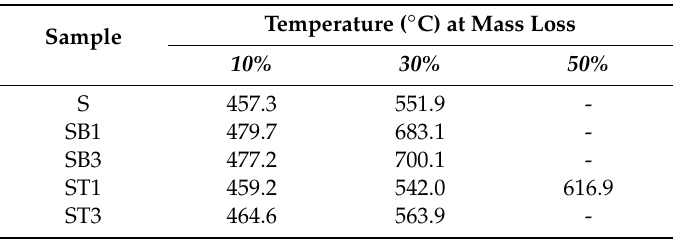
Table 2. TG data for pure Sylgard and its